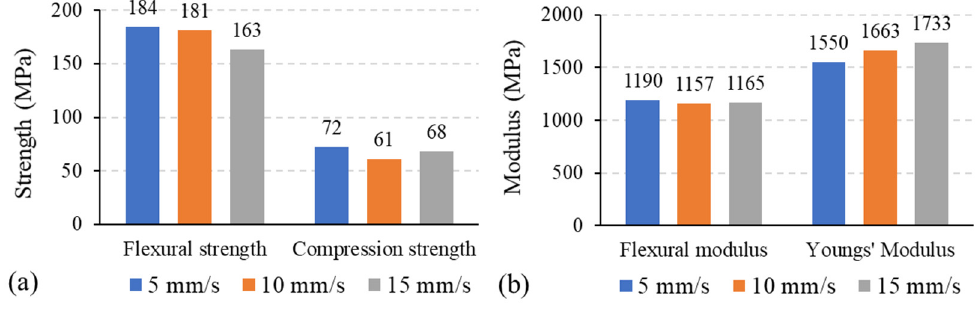
Figure 14. PEEK ( a ) strength and ( b ) modulus sensitivity to printing speeds.